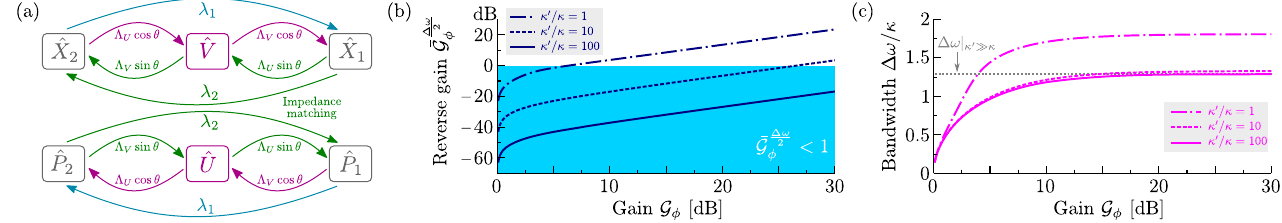
FIG. 6. Properties of the directional phase-sensitive amplifier. (a) Sketch of couplings and drivings used to impedance match the ¯ G ω (cid:2) for ω set to half of the amplification bandwidth Δ ω , for various choices of the auxiliary-mode damping amplifier. (b) Reverse gain ϕ ½ ¯ G 0 (cid:2) ¼ 0 . (c) Amplification bandwidth Δ ω as a function of zero-frequency rate κ 0 . On resonance, we always have perfect directionality: ϕ ½ forward gain G ϕ for various values of κ 0 . The amplifier does not suffer from a standard gain-bandwidth